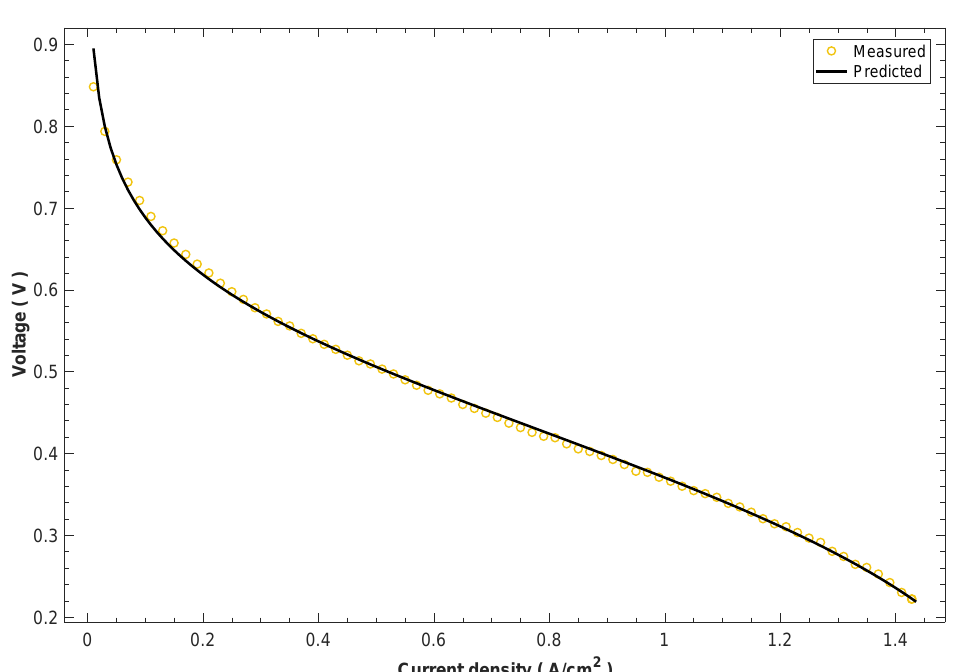
Figure 6. Modeled polarization curve using the computed unknown parameters through NNA, at 28% RH.